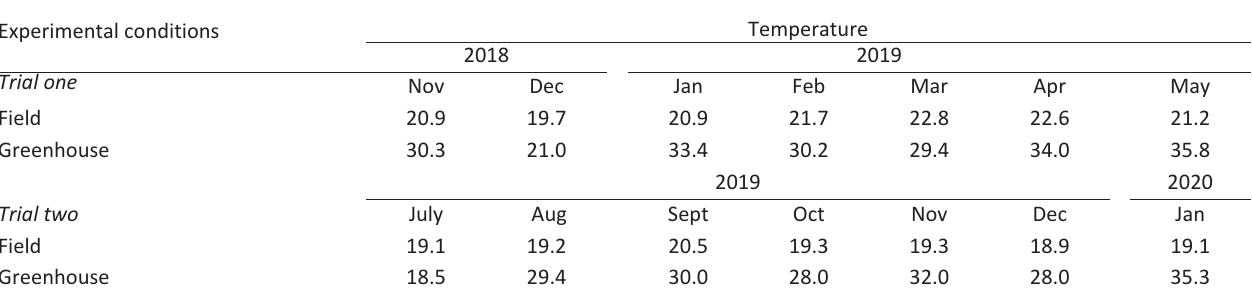
Table 1 ­ Average monthly field and greenhouse temperature (°C) in trial one and two Experimental